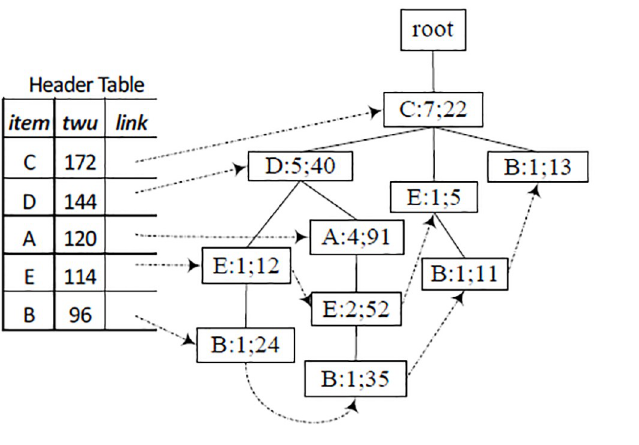
Fig 6. UP-Tree [10] based on toy data in Tables 1 and 2 ( η = 70).